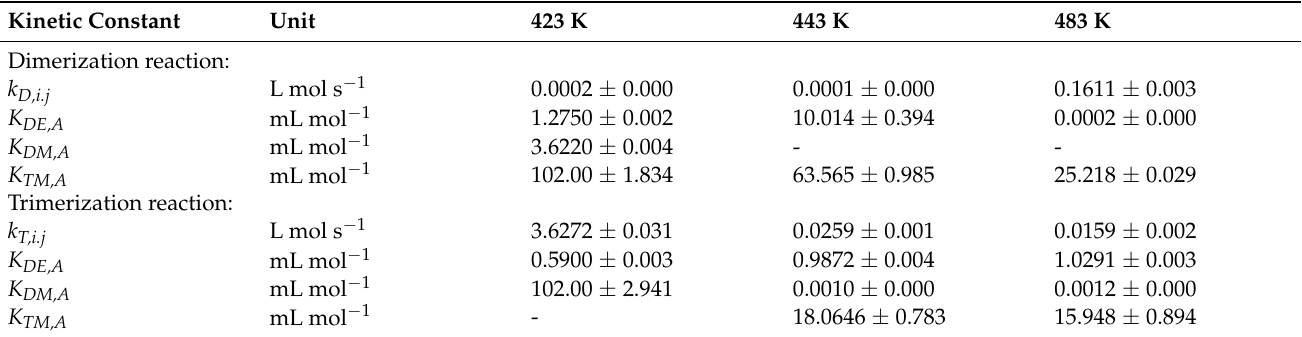
Table 2. Kinetic constant values derived from the non-linear regression method of the best-fit kinetic models.